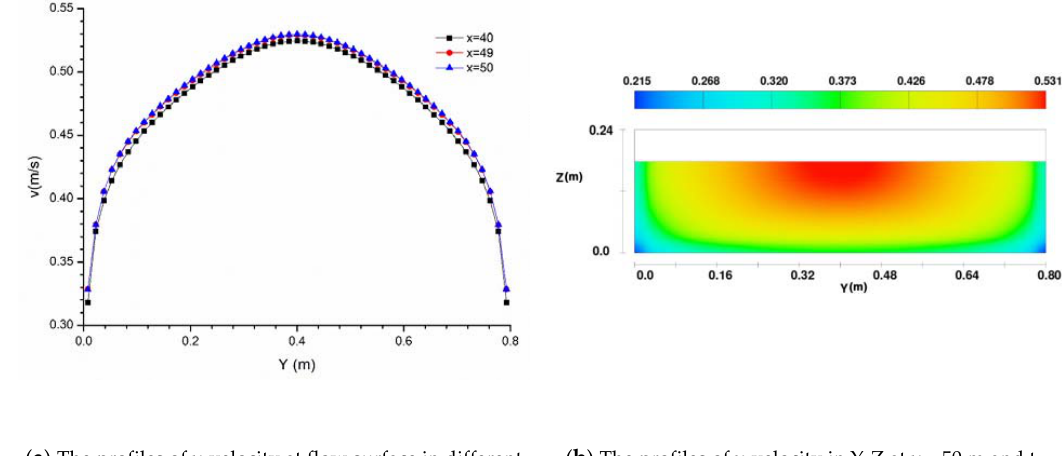
Figure 4. The profiles of x-velocity in the channel without a pier.